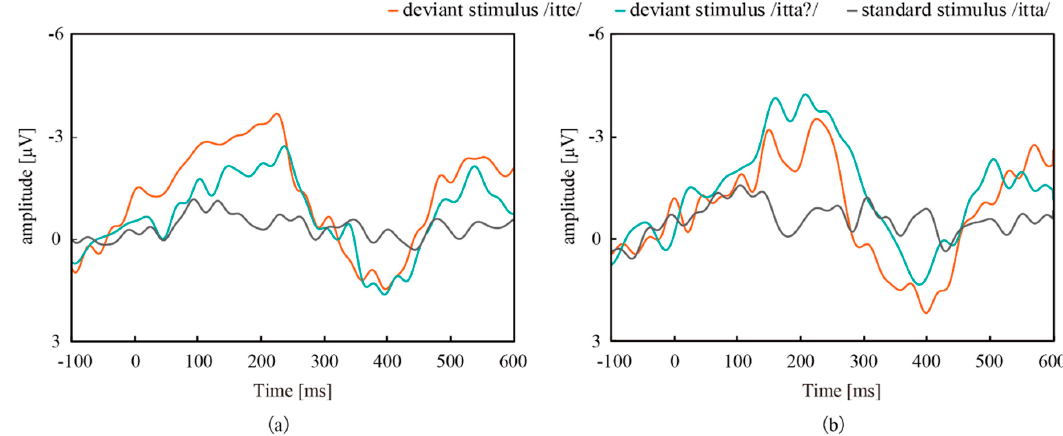
Figure 11. Grand mean waves of EEG-based ERPs measured at ( a ) T3 and ( b ) T4. The ERPs to the deviant stimuli from both measurement sites captured MMN and P300.